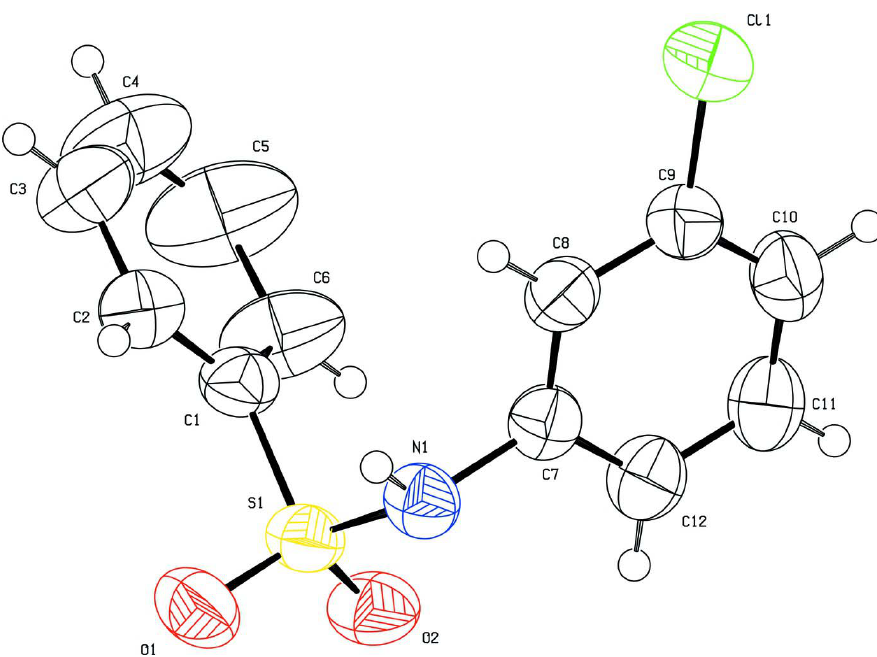
Figure 1 Molecular structure of the title compound, showing the atom labelling scheme. Displacement ellipsoids are drawn at the 50% probability level. H atoms are represented as small spheres of arbitrary radii.